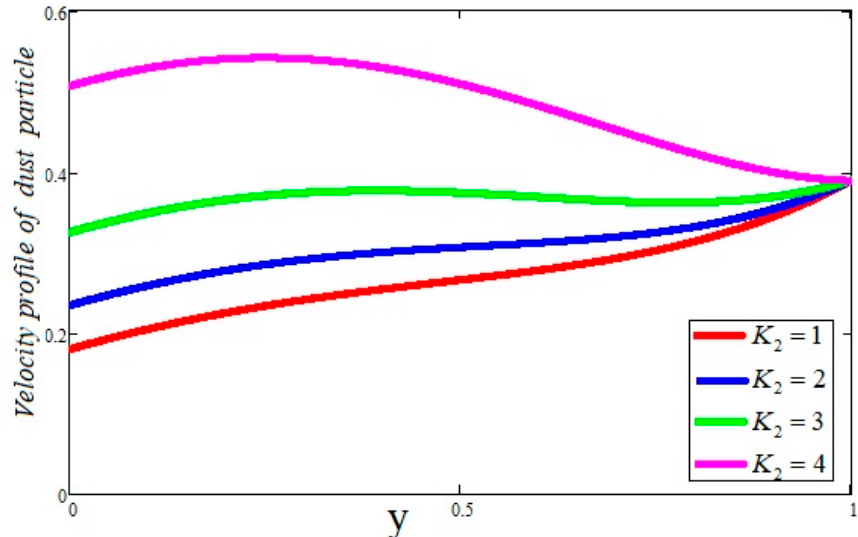
Figure 5. Impact of K 2 on the profile of dust particles velocity.